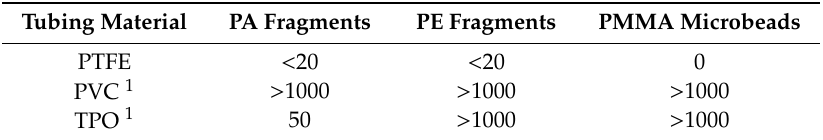
Table 2. Number of adhering microplastic particles sized between 1 and 300 µm on 1 cm² of the inner tube surface.